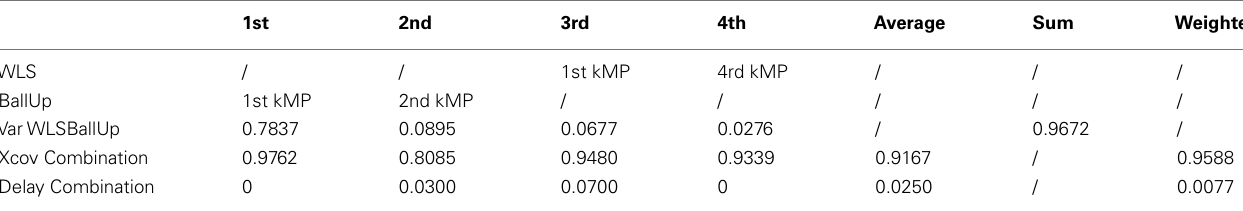
Table 10 | Combination of the kMPs of walking and the kMPs of reaching (2